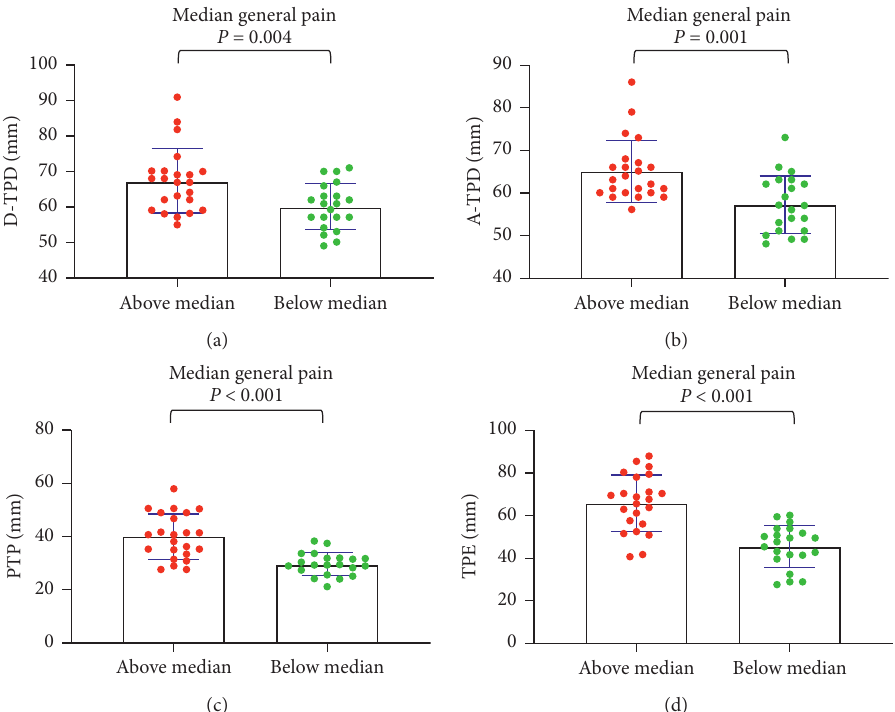
Figure 3: Tactile acuity for median general pain in the abovemedian group versus the belowmedian group. (a) D-TPD, (b) A-TPD, (c) PTP, and (d) TPE. The median of general pain intensity was 4. D-TPD � two-point discrimination test performed in a descending manner; A- TPD � two-point discrimination test performed in an ascending manner; PTP � point-to-point test; TPE � two-point estimation.